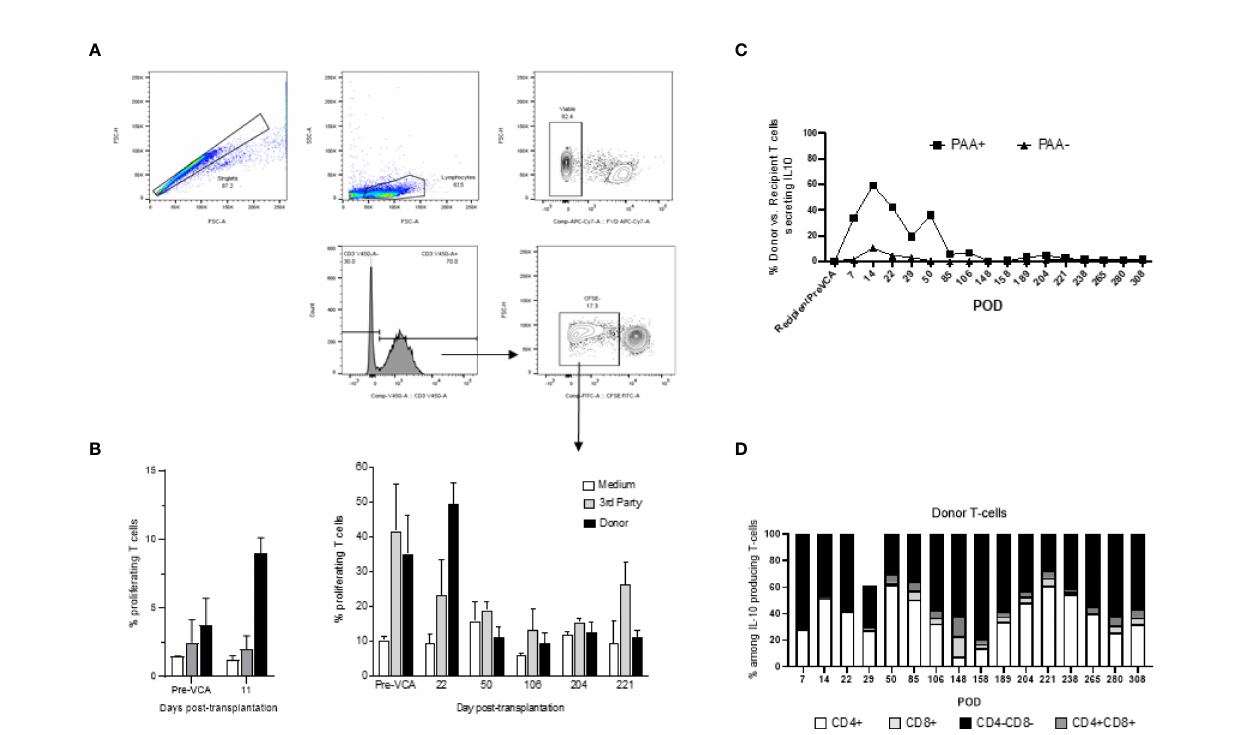
FIGURE 6 | (A) Gating strategy for mixed lymphocyte reaction (MLR) assay. Cells analyzed in this assay were fi rst gated as singlet events, followed by gating on the major lymphocyte population. Fixable viability dye negative events (viable) were analyzed for CD3+ expression. This population was characterized based on CFSE fl uorescence, where proliferating T-cells were denoted as CFSE dim and plotted as a proportion of total CD3+ events. (B) Mixed lymphocyte reaction assay testing proliferation of T cells in vitro (left panel untreated controls, right panel tolerant chimeric recipients). Untreated control animals demonstrate increased T-cell proliferation against donor targets at time of rejection (left panel), whereas tolerant animals have decreased T-cell responsiveness towards the donor overtime (right panel). From POD 50 onwards, which corresponds more or less to the withdrawal of all immunosuppression and establishment of multi-lineage mixed chimerism, cellular proliferation against donor and self-antigens were comparable to medium, suggesting a state of immune unresponsiveness in peripheral blood (right panel). (C) Similar to Figure 3 which showed equilibration of donor (PAA+) and recipient (PAA-) contribution to overall T cell populations, the contribution of IL-10 secreting T cells followed a similar pattern, approaching equilibrium at POD 85. Further analysis revealed that the majority of such IL-10 producing T cells are CD4-CD8- in nature (D) . The results shown in panel (C, D) were obtained in one tolerant swine and are representative of all tolerant swine tested